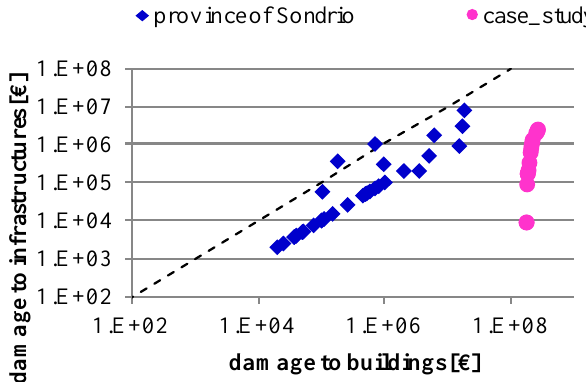
Fig. 7. Comparison between damage to buildings and damage to infrastructures (pink circle) for the case study and (blue rhombus) Figure 7. Comparison between damage to buildings and damage to infrastructures (i) for the 2 for the event of November 2002 in the Province of Sondrio. The log scale has been assumed for both axes. The dotted line indicates the case study and (ii) for the event of November 2002 in the Province of Sondrio. The log scale 3 equality of values. has been assumed for both axes. The dotted line indicates the equality of values. 4